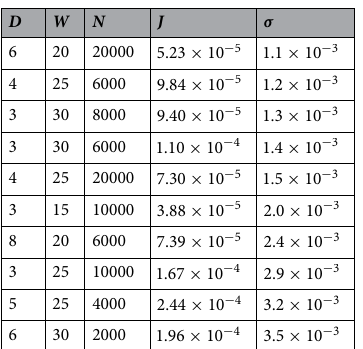
Table 2. Standard error ( σ ) and loss function ( J ) corresponding to different parameters, depth ( D ), width ( W ), and number of data ( N